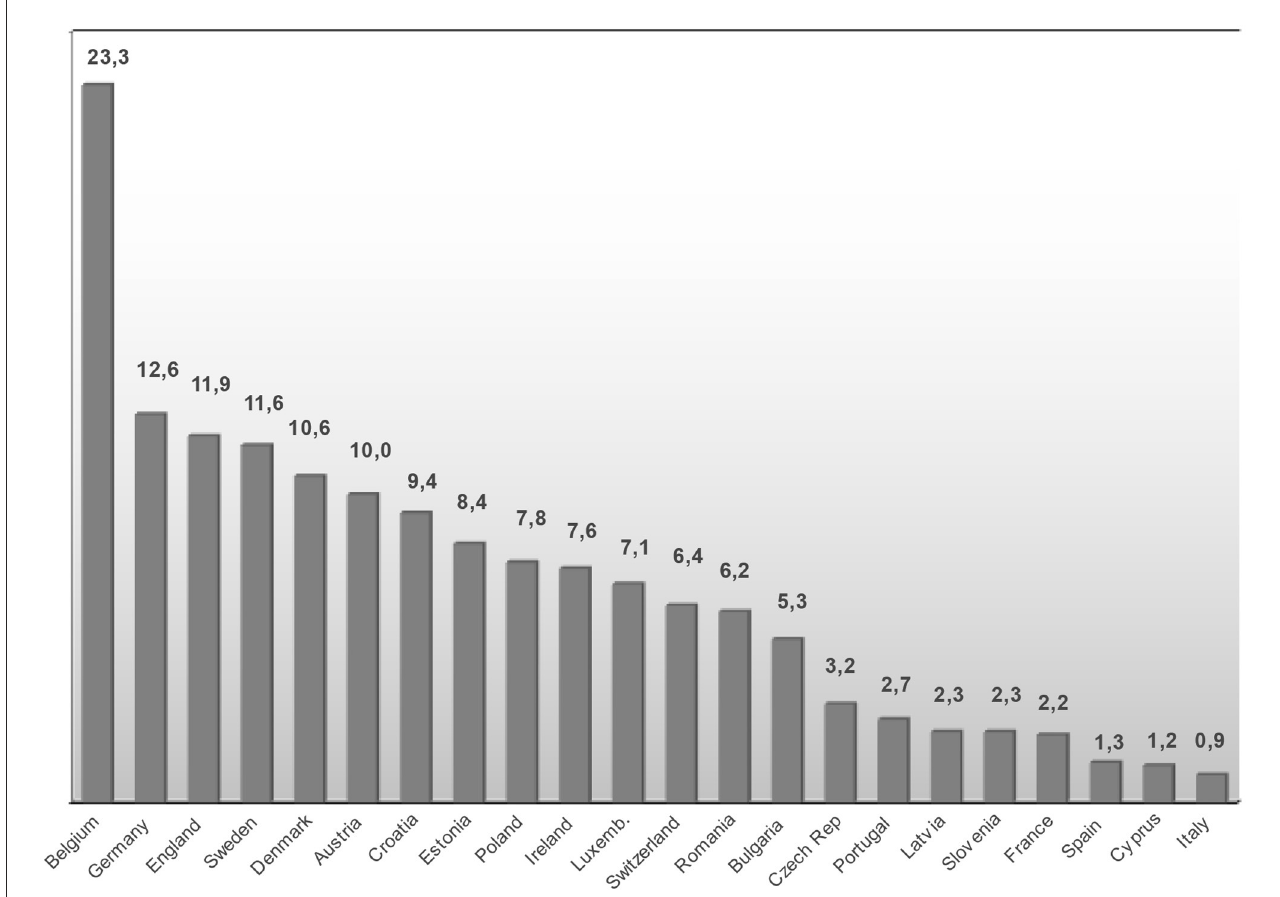
mentioned have failed to return information on the respective